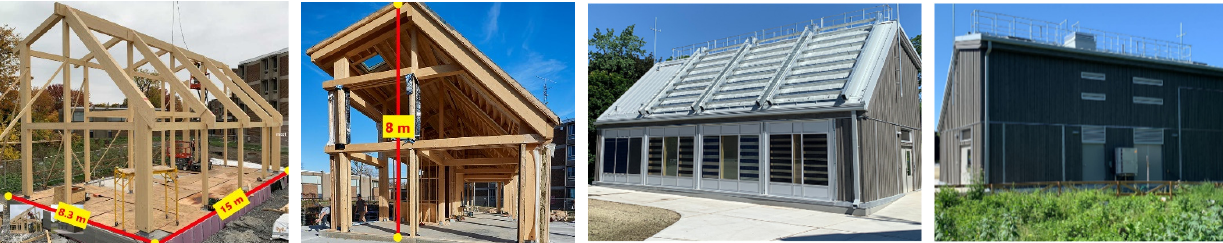
Figure 3. Future Buildings Laboratory.